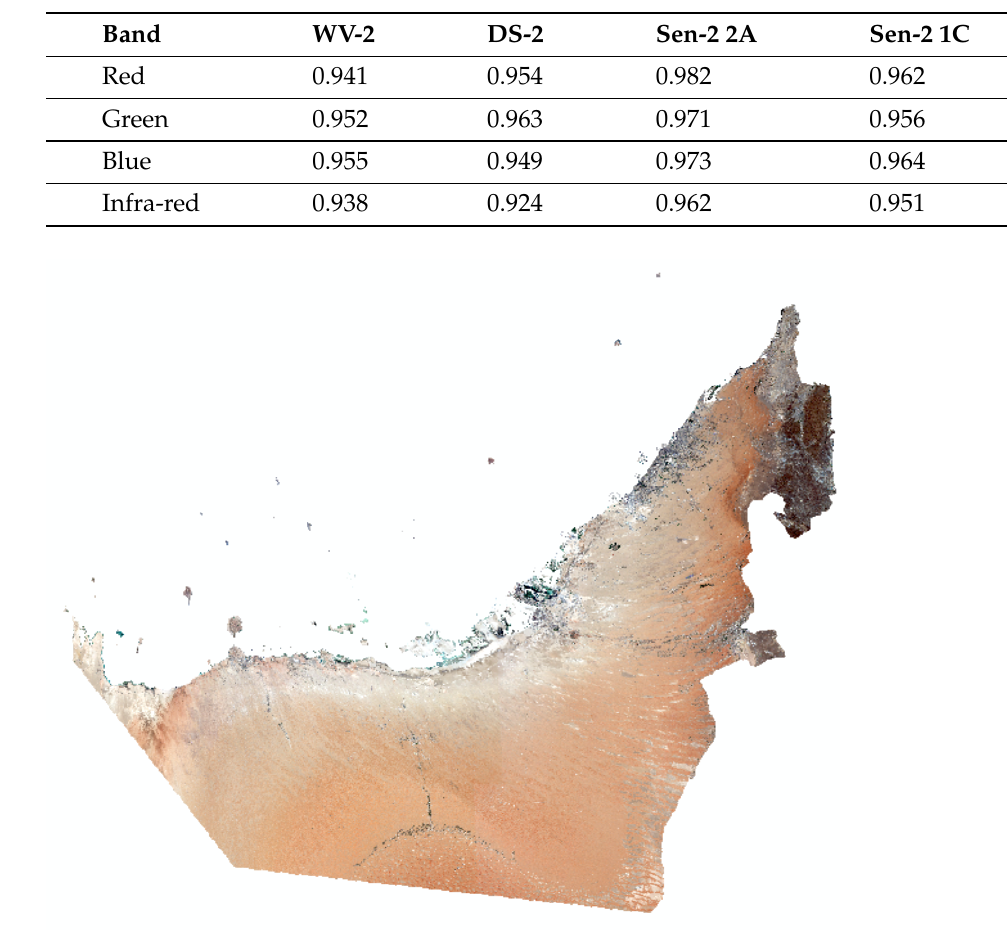
Table 1. Correlation coefficient (C.C.) between reference base image and the final mosaic image.